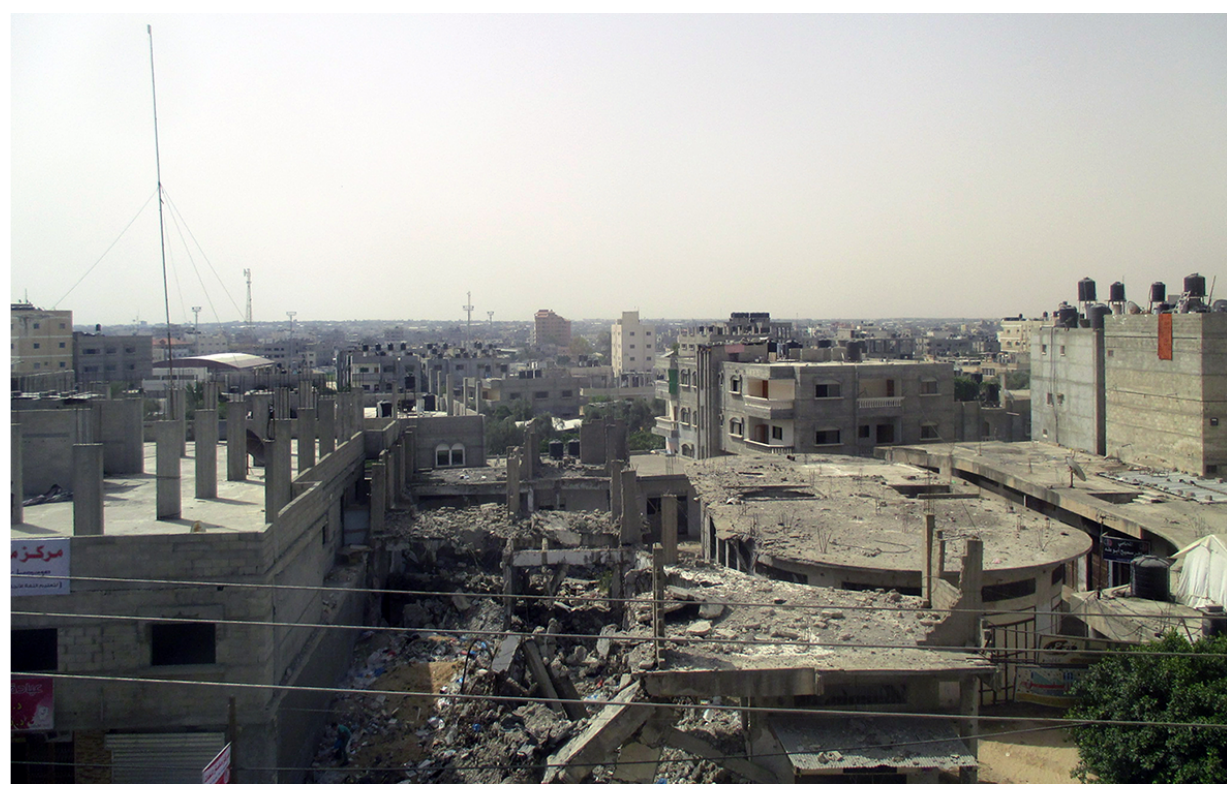
Figure 1. Khan Yunis in the south of the Gaza Strip. Destroyed or ruined buildings are a common impression in the dense urban